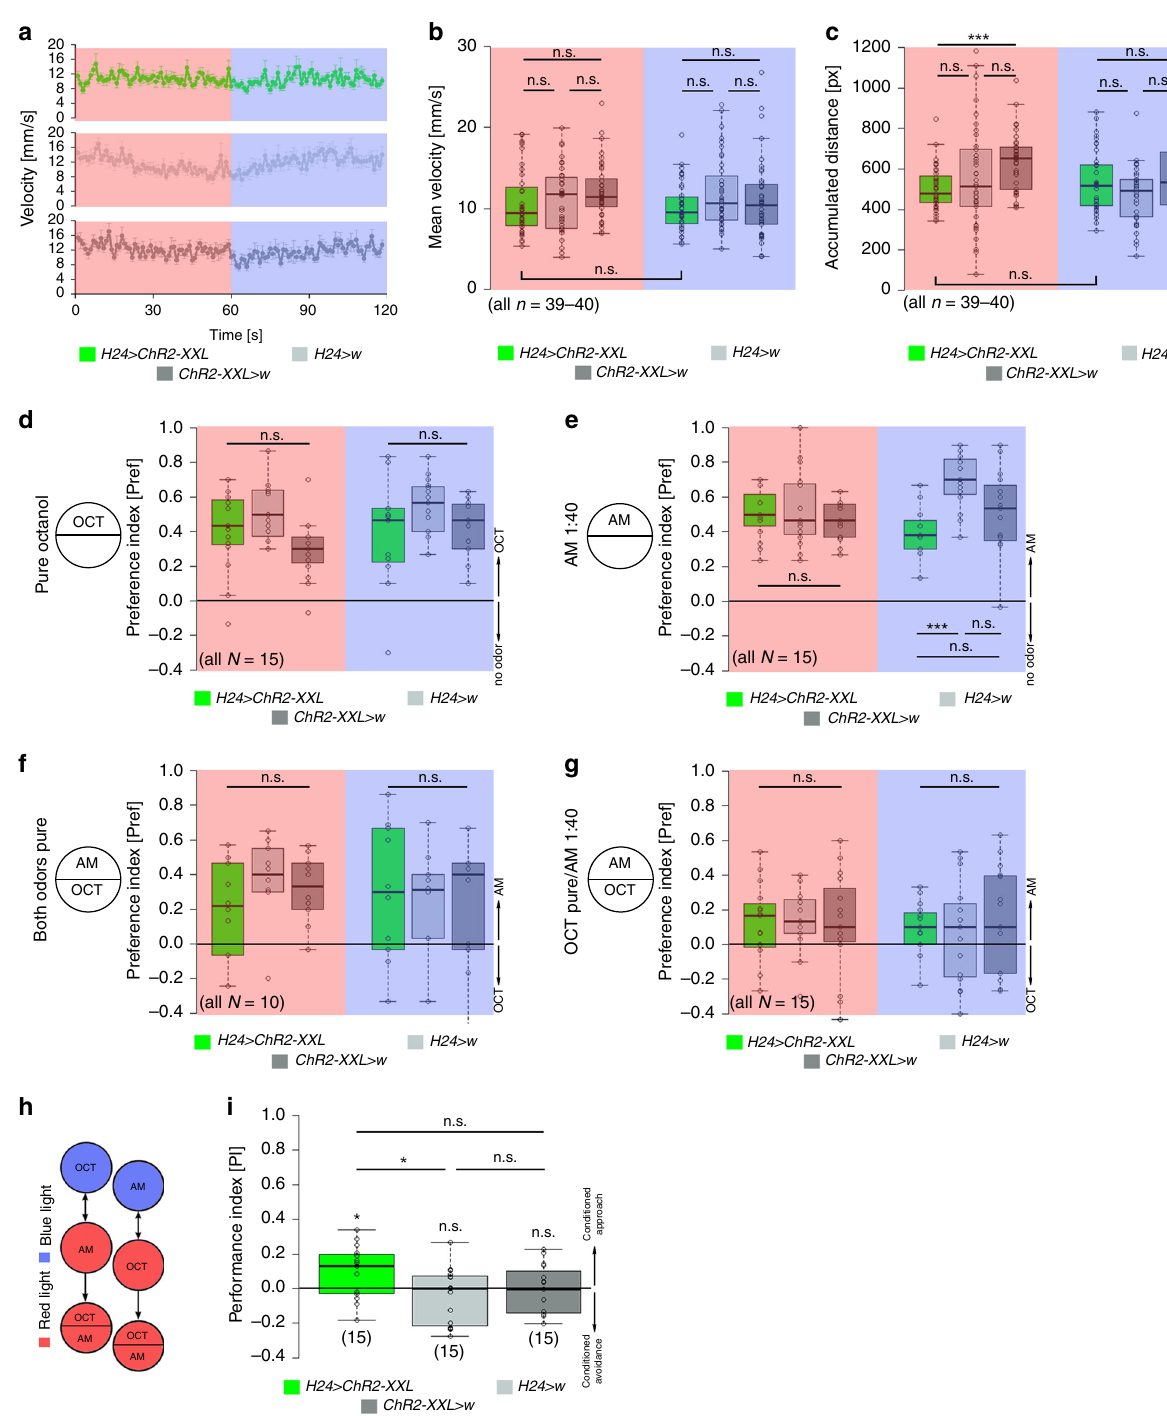
Fig. 2 Optogenetic activation of KCs does not alter locomotion or odor responses. a – c Conditional optogenetic activation of KCs does not change larval velocity ( a , b ) and accumulated distance ( c ). The light regime is indicated by the red and blue rectangles: larvae were monitored under red light for 1 min, subsequently under blue light for another minute. d – g Similarly, innate odor preference to OCT ( d ) and diluted AM ( e ) is not altered due to conditional optogenetic activation of KCs. In line, experimental larvae showed normal performance in an odor discrimination task using OCT and either pure AM ( f ) or 1:40 diluted AM ( g ). h , i Conditional optogenetic activation of KCs is suf fi cient to induce an appetitive memory using a 2-odor reciprocal training regime indicating that experimental larvae can distinguish different odors despite arti fi cially activated KCs. AM: amylacetate; ChR2-XXL: channelrhodopsin2-XXL; KCs: Kenyon cells; OCT: octanol; w: w 1118 . The number below the box plots refers to the N number. A pairwise Student ’ s t test or pairwise Wilcoxon test (both including Bonferroni-Holm correction) was used. Signi fi cance levels: n.s. p > 0.05, * p < 0.05, ** p < 0.01, *** p < 0.001. Error bars ( a ) represent the standard error of the mean. Data are mainly presented as box plots, with 50% of the values of a given genotype being located within the box, and whiskers represent the entire set of data. No data were excluded. Outliers are indicated as open circles. The median performance index is indicated as a thick line within the box